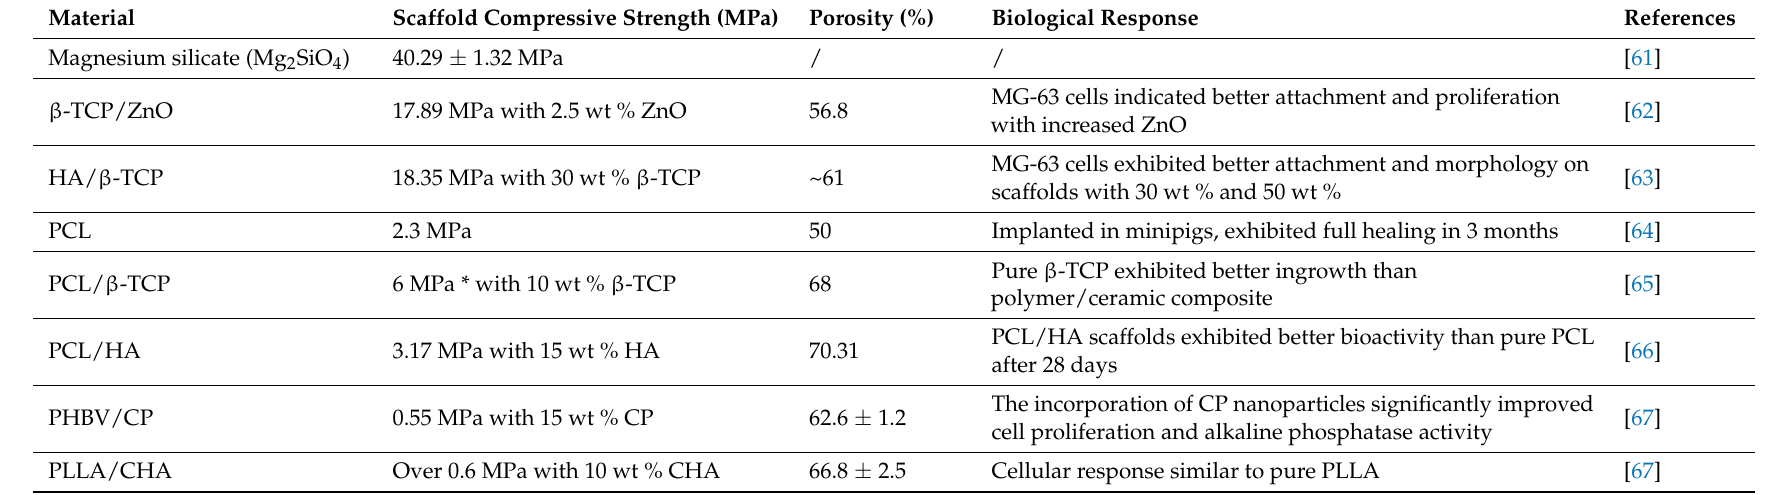
Table 2. Summary of SLS Scaffold